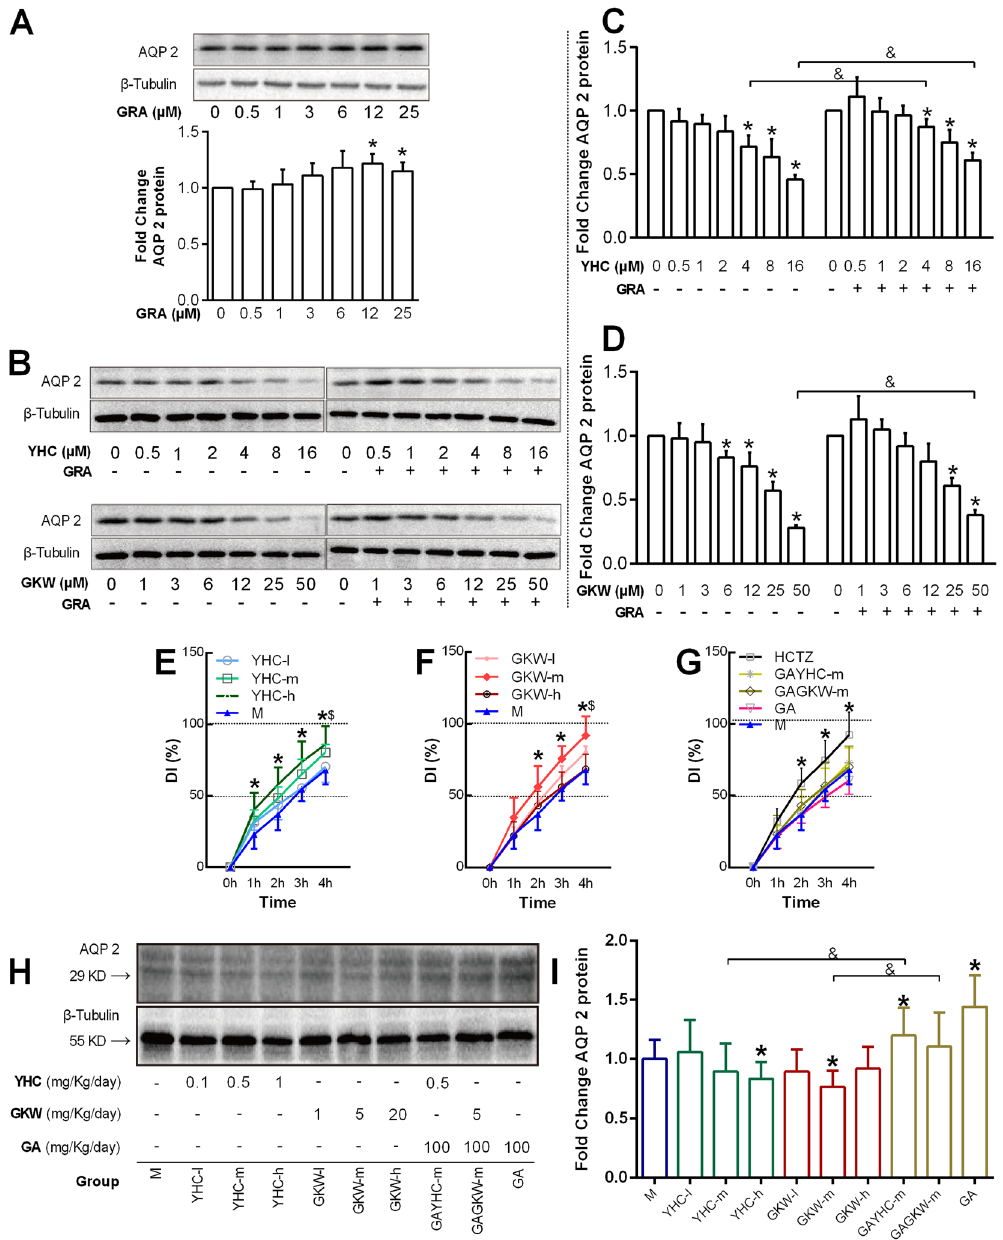
Figure 5. YHC, GKW and GRA (GA) are responsible for changes in AQP 2 regulation and diuresis effect in vitro and in vivo . The mIMCD-3 cells were planted in 6 well plate and cultured in RPMI1640 medium supplied with 10% fetal bovine serum. All doses were given during cell logarithmic phase, and the highest doses were restricted until cell proliferation was not affected. ( A ) Blotting image of AQP 2 expressed by mIMCD3 cells treated by GRA for 24 hours. Bar chart of fold changes is given, and concentrations are labeled below. ( B ) Blotting image of AQP 2 expressed by mIMCD3 cells treated by YHC, GKW singly or in combination with GRA, for 24 hours. When GRA was combined, the working concentration was 12 μ M. The blots was cropped properly and the full length blots are presented in Supplementary Fig. S6. ( C to D ) Bar chart for AQP 2 expression with different treatment as with in ( B ) * P < 0.05 when compared with control group (none drug- treated), & P < 0.05 compared between groups with or without GRA treatment (n = 3). ( E to G ) Low, middle and high doses of YHC, GKW as well as special doses of HCTZ, GA and GA-YHC combination, GA-GKW combination were all submitted to diuresis mice model. Accumulated urine output was calculated from animal weight loss 0 to 4 hours after NS loading. The data were represented as DI. ( H and I ) representative blotting image and bar chart of renal total AQP 2 levels treated by different chemicals and their combination. Doses of each group are given below the image. * P < 0.05 when YHC-h or GKW-m groups compared with M group, $ P < 0.05 when YHC-m or GKW-l compared with M group, & P < 0.05 when compared between groups with or without GA treatment (n = 6). The blots was cropped properly and the full length blots are presented in Supplementary Fig.